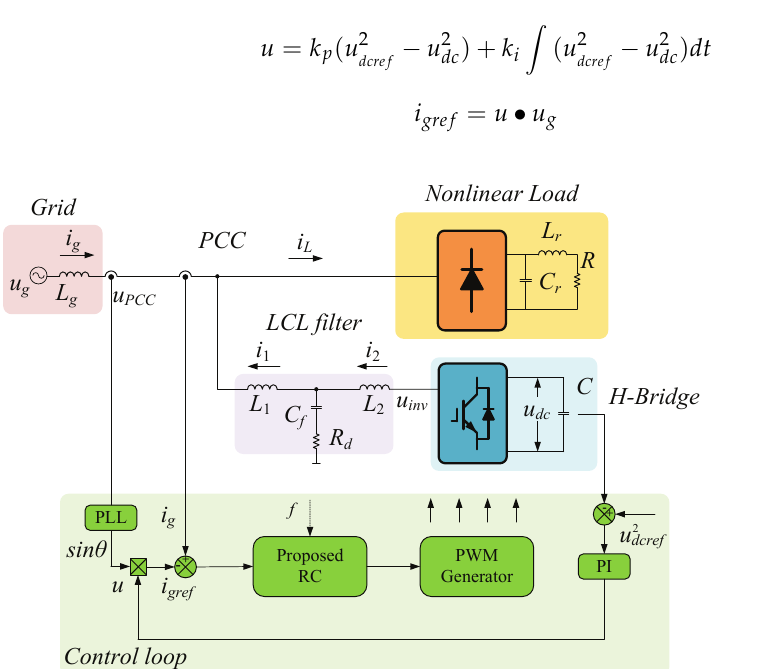
Figure 12. Single-phase shunt APF system.